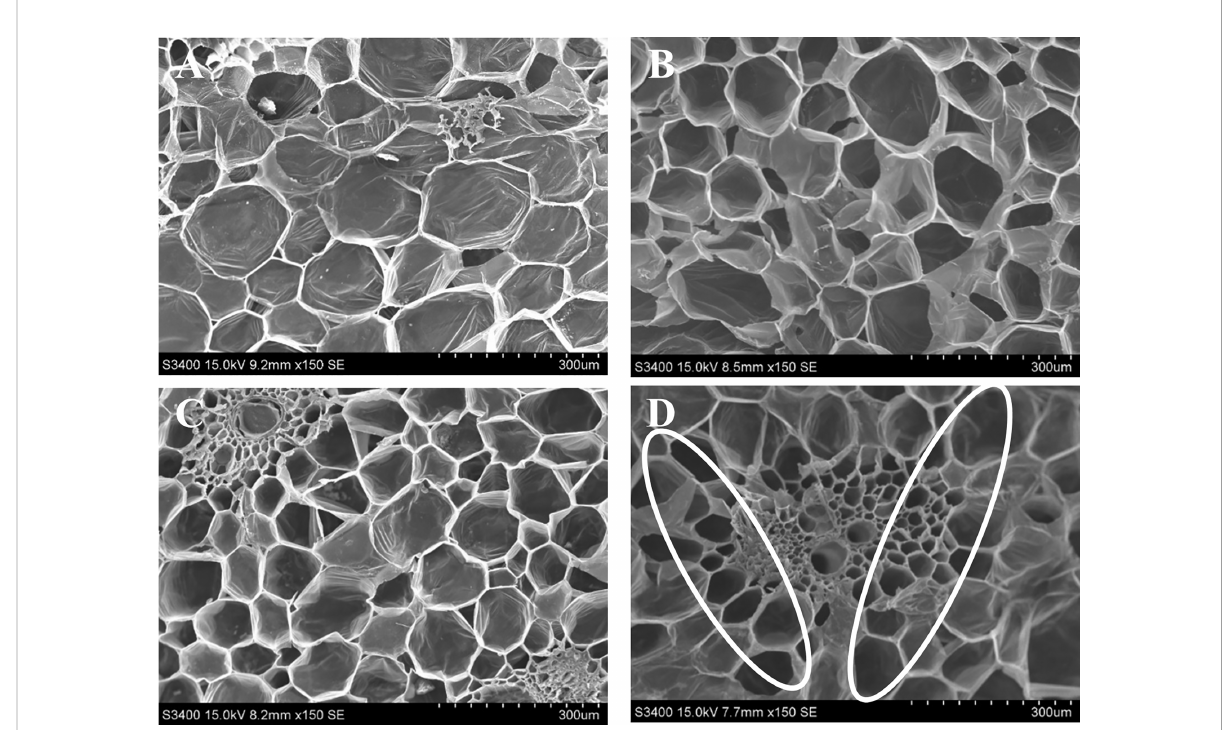
FIGURE 3 SEM characterization of stem ends of bird of paradise treated with (A) Control, (B) GO at 1 µL L − 1, (C) SNP at 1 µL L − 1 , and (D) GO + SNP at 1 µL L − 1 at 12 (D) Scale bars: 300 m